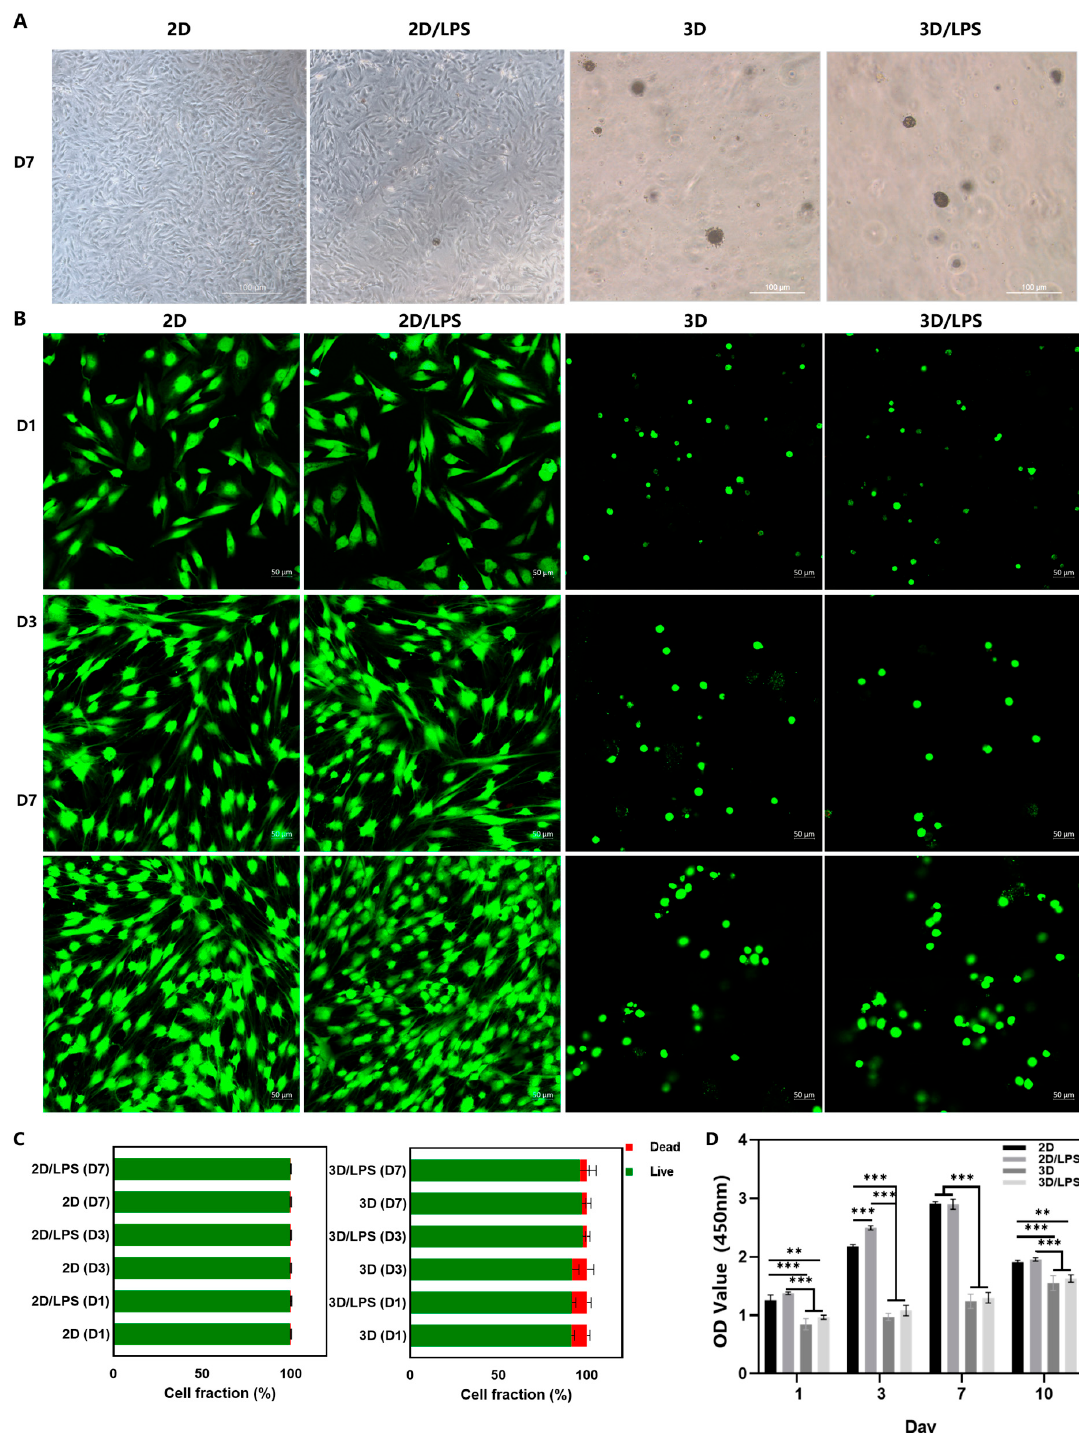
Figure 5. Growth, viability and proliferation of PDLSCs in SupraGel. ( A ) Morphology of PDLSCs and LPS-pretreated PDLSCs under light microscope; scale bar—100 µm. ( B ) Live/Dead image under laser scanning confocal microscope; scale bar—50 µm, green—live cells, red—dead cells. ( C ) Semi-quantitative analysis of the Live/Dead assay. ( D ) CCK8 proliferation assay of PDLSCs and LPS-pretreated PDLSCs after culturing in culture plates and SupraGel on days 1, 3, 7 and 10. 2D—PDLSCs in cell culture plate; 2D/LPS—LPS-pretreated PDLSCs in cell culture plate; 3D—PDLSCs in SupraGel; 3D/LPS—LPS-pretreated PDLSCs in SupraGel. D1—Day 1; D3—Day 3; D7—Day 7. ** p < 0.01; *** p < 0.001.